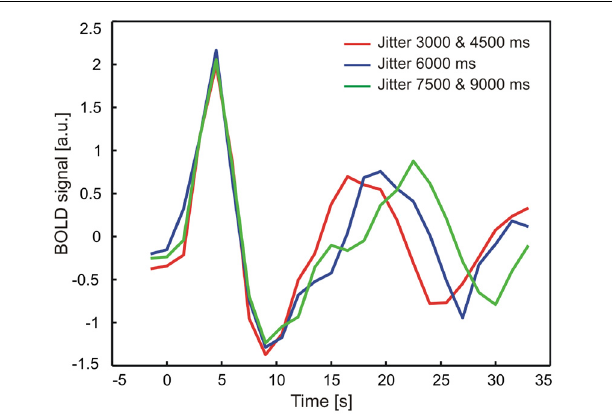
FIGURE A1 | Mean time course of neural activity in auditory cortex as a function of jitter between sound and reward presentation. In a model-free approach, individual time courses were extracted and time locked to the sound presentation in a sphere of radius 6mm around the peak maximum activation in the right auditory cortex [ x, y, z ] = [50, − 2, 4]. Time courses were grouped according to different jitter lengths (red: 3000, 4500ms, blue: 6000ms, green: 7500, 9000ms) to visualize the time course during sound as well as feedback presentation. The results of this analysis clearly showed that there is no major contamination of the measured brain activity during feedback presentation which resulted from the sound